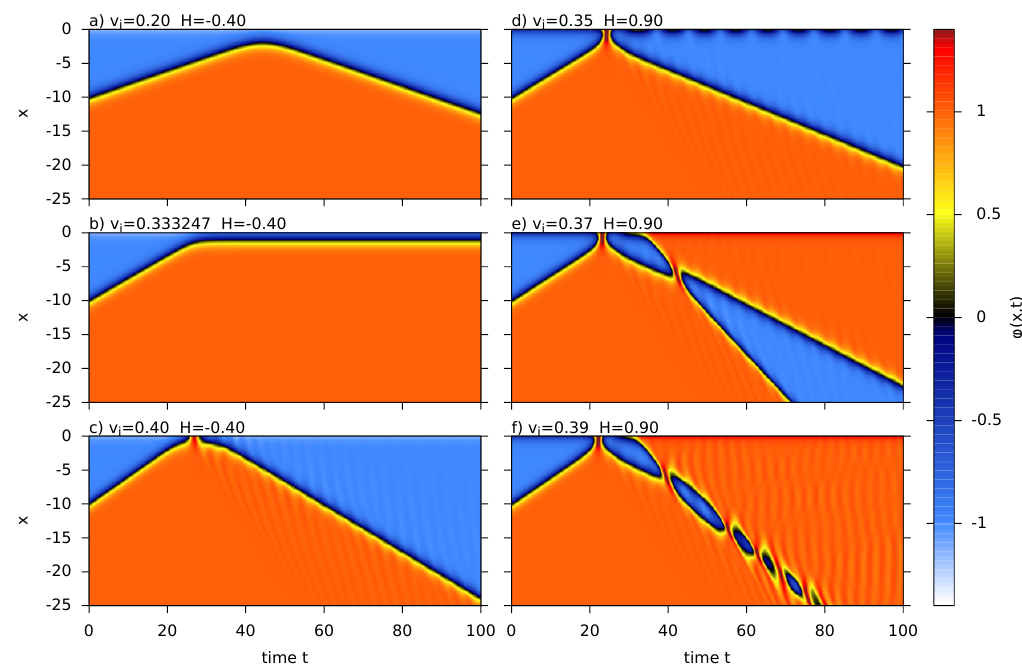
Figure 4 . Example collisions for H = (cid:0) 0 : 4 (left column) and H = 0 : 9 (right column), illustrating various scattering scenarios. At negative H : (a) elastic recoil for low impact velocity; (b) saddle point production at the critical velocity, the antikink (cid:12)nishing on the top of the potential barrier; (c) single bounce with the antikink escaping back over the barrier. At positive H : (d) single bounce with the excitation of the H > 0 boundary mode; (e) kink production via collision-induced boundary decay; (f) bulk oscillon production. See also movies M01 { M07 and M11 of appendix B. j H j (cid:28) 1 and j x j (cid:29) 1 we (cid:12)nd that the boundary condition requires e (cid:0) 2 x 1 = 1 0